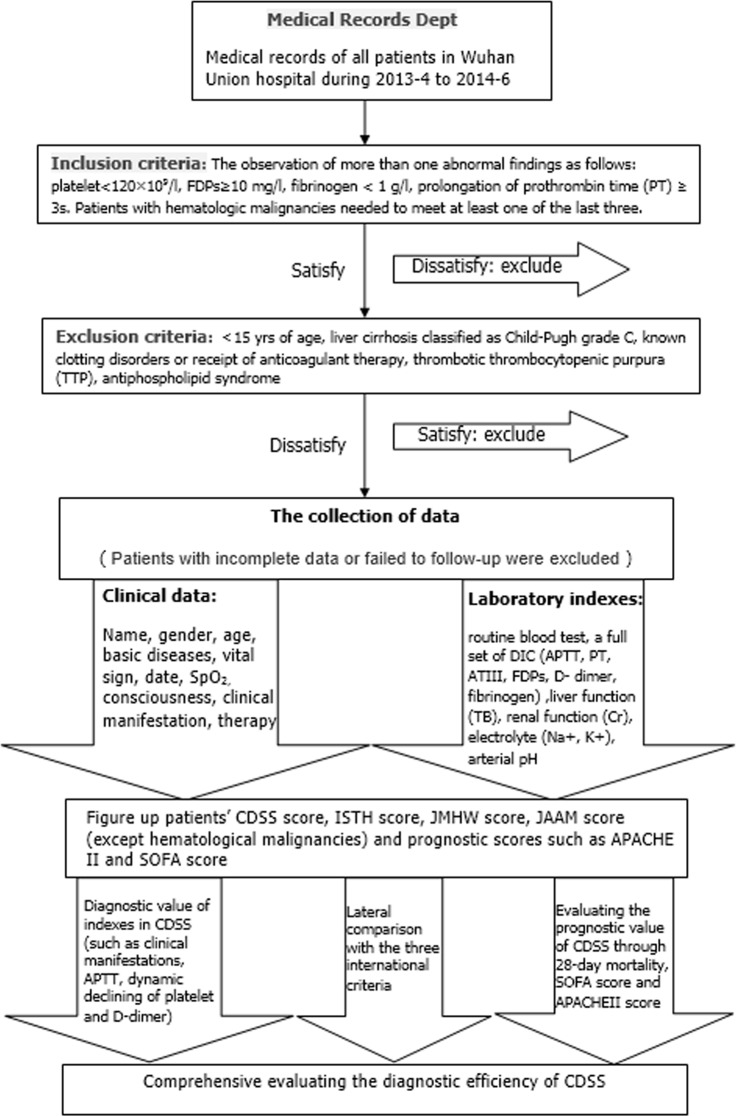
The flow diagram of the whole study process.